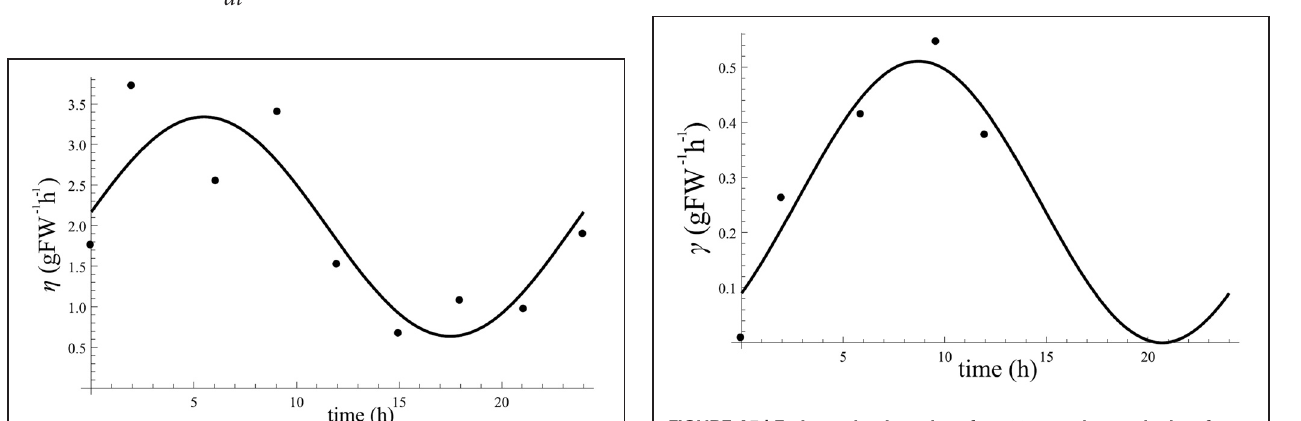
FIGURE A5 | Estimated point values for γ ( t ) at each sample data from Figure 2A using constant ¯ β . The curve is the result of fitting a cosine to the estimation points of γ ( t ) . By fitting a cosine function to the obtained estimations for γ ( t ) we obtain a γ = 0 . 51, b γ = 0, and φ γ = 7 . 8.